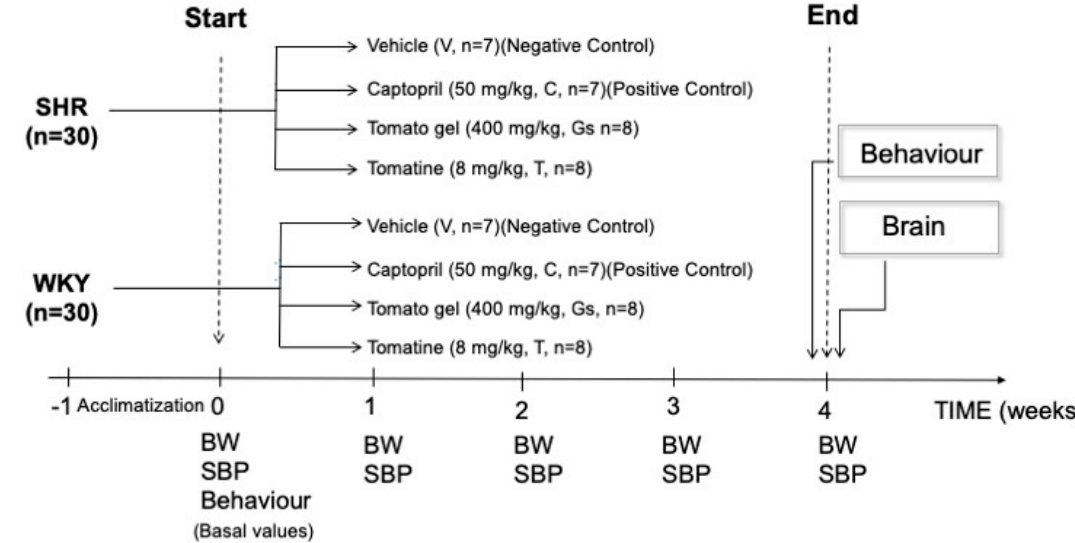
Figure 1. After a one-week housing period (acclimatization period) both Wistar Kyoto (WKY) and spontaneously hyper- tensive rats (SHRs) were randomly assigned and treated for four weeks, during which body weight (BW) and systolic blood pressure (SBP) were measured on a weekly basis. Basal SBP and basal weight were obtained just before starting any treatments, while behavioral parameters were assessed on the day before the treatments (basal behavior) and on the day before the end of the treatments (sacrifice day). After the animals were sacrificed, the brains were collected for ex vivo experimentation on brain slices.